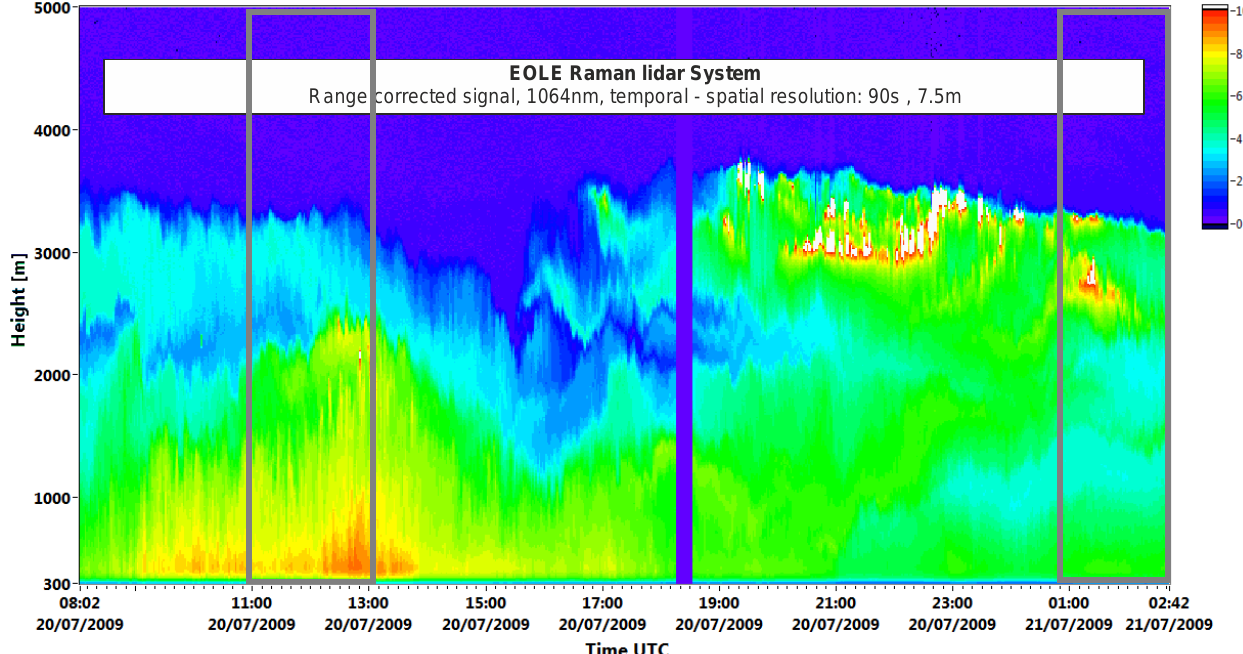
Fig. 3. Temporal evolution of the range-corrected lidar signal (RCS) in arbitrary units (AU) obtained over Athens at 1064 nm, between 08:02UTC (20 July 2009) and 02:42UTC (21 July 2009). The grey panels refer to the aircraft flight periods.